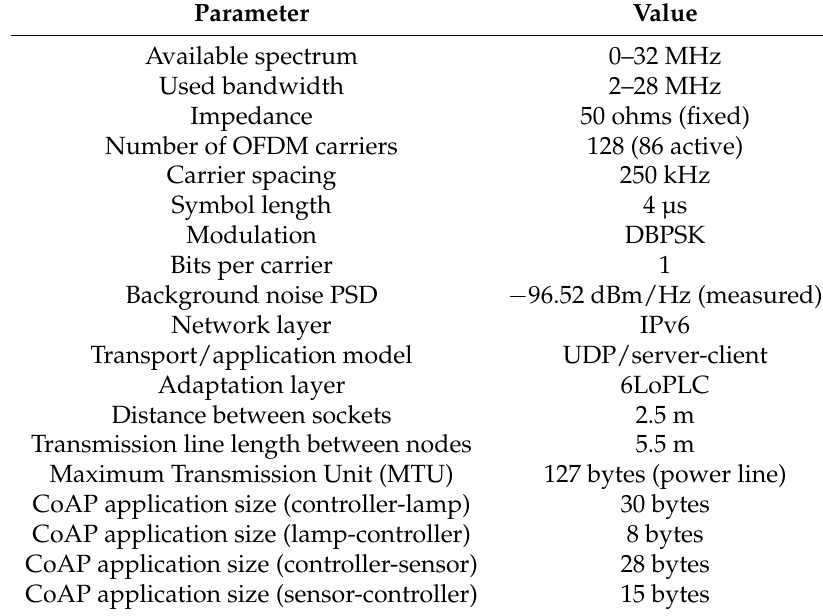
Table 1. System parameters. OFDM: orthogonal frequency-division multiplexing, PSD: power spectral density, UDP: user datagram protocol, DBPSK: differential binary phase shift